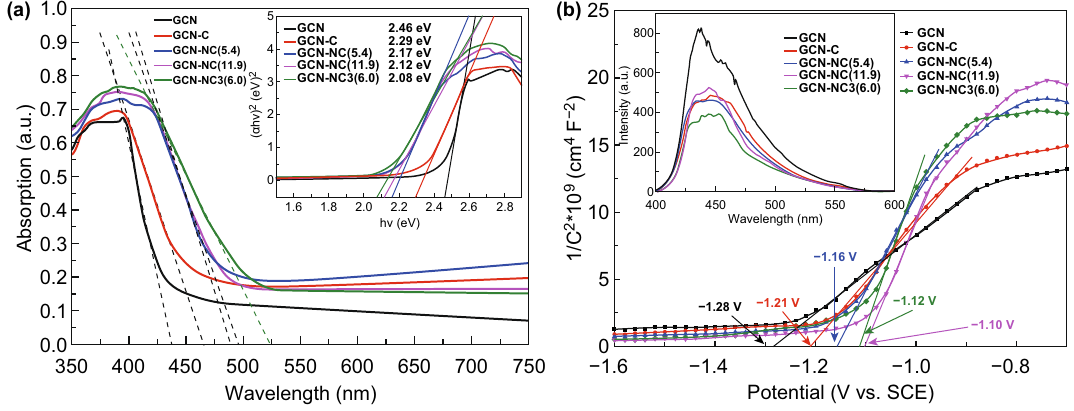
Fig. 3 a UV–Vis diffuse reflectance absorption and b Mott–Schottky of GCN and NC-loaded GCN. The inset in a shows plots of (αhν) 2 versus photon energy (hν) for the band gap energy; the inset in b shows the photoluminescence spectra of the